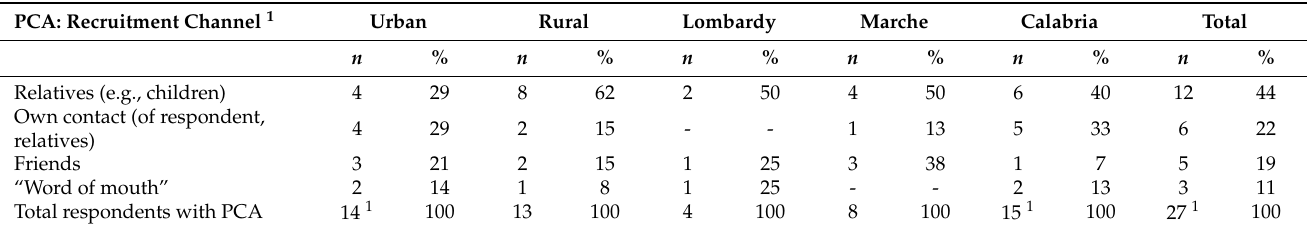
Table 6. PCA presence: recruitment by sites and